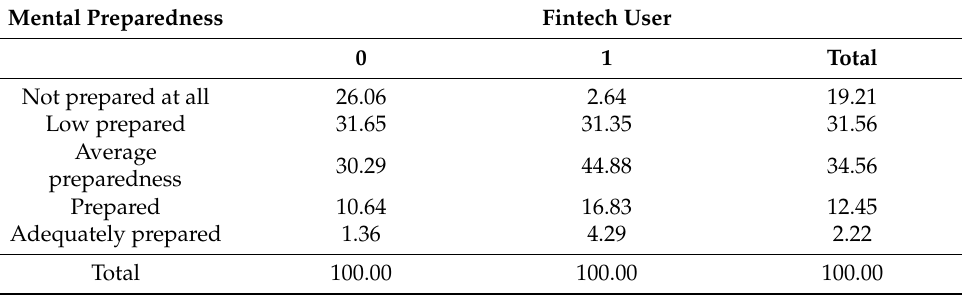
Table 3. Crosstab of Mental Preparedness and Fintech